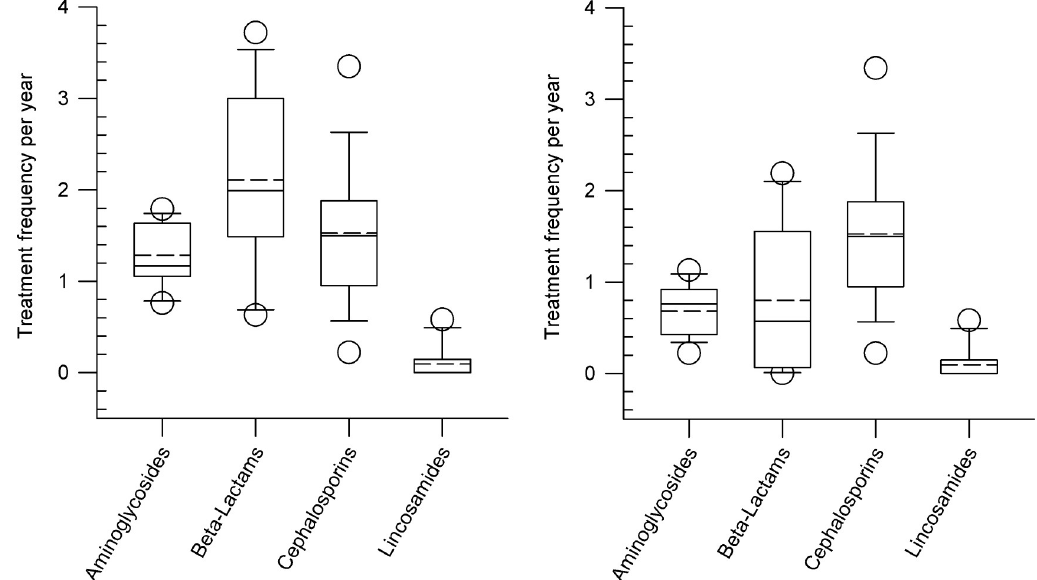
Fig 4. Administration of different antimicrobial classes after intramammary application expressed as treatment frequencies per animal and year on nine dairy farms. A: Intramammary application including dry-cow therapy (DCT), B: Intramammary application without DCT. Box, the range between the 1 st (Q1) and 3 rd (Q3) quartile; horizontal line, median; dashed line, mean; circles, outlying points (5 th , 95 th percentiles, respectively).